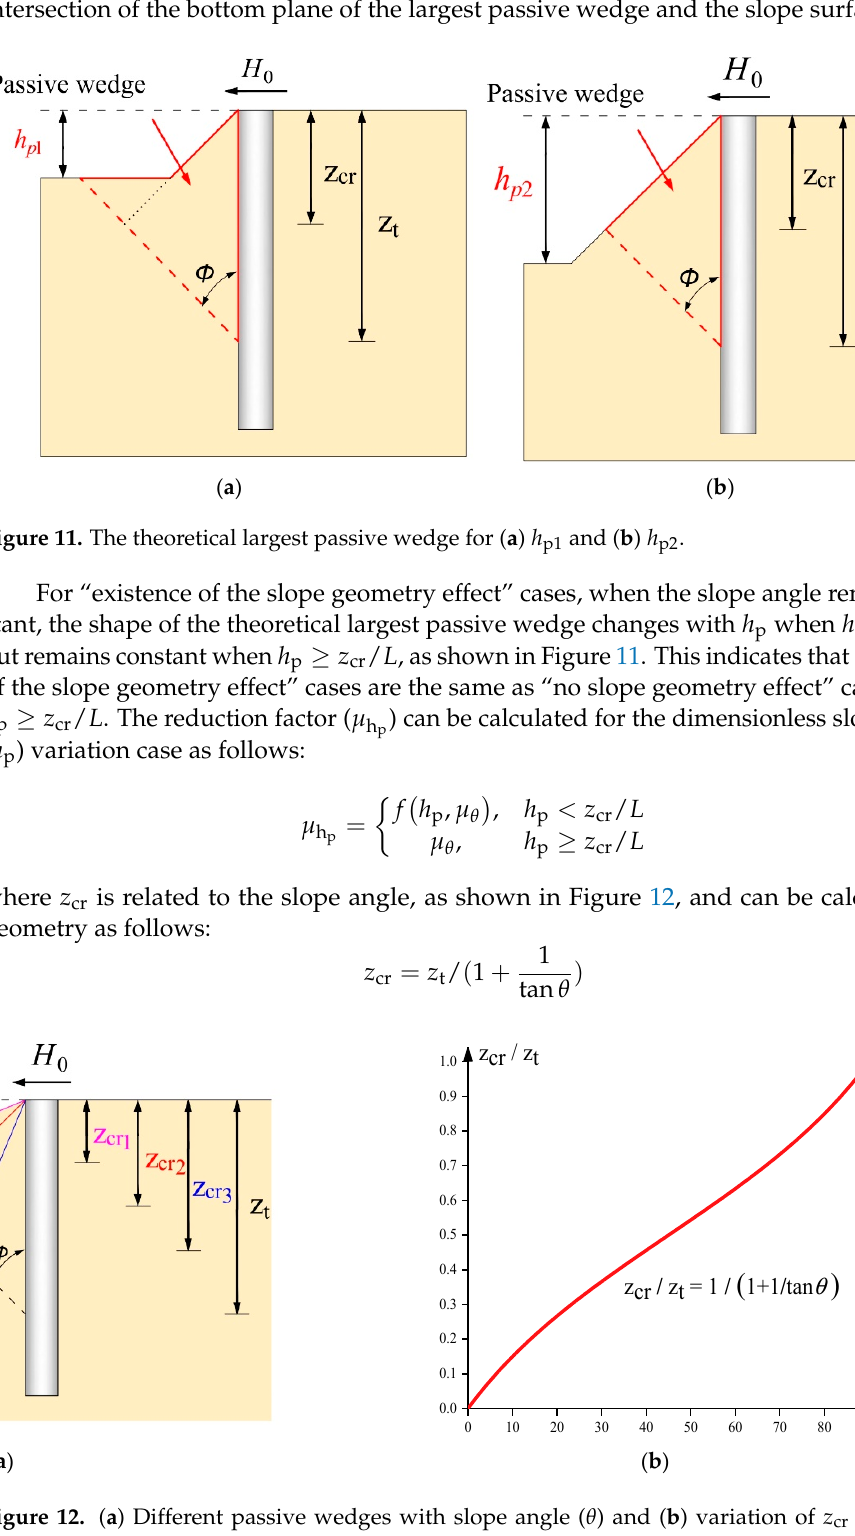
Figure 10. The wedge failure model at shallow depth for level ground. ( a ) 𝐻 (cid:2868) and ( b ) 𝐻 (cid:2869) .